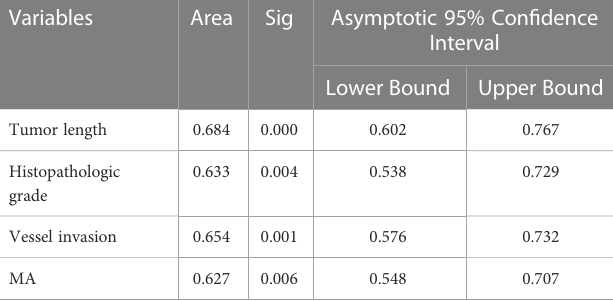
TABLE 6 ROC analysis results of multiple factors for predicting the lymph node metastasis of gastric cancer.